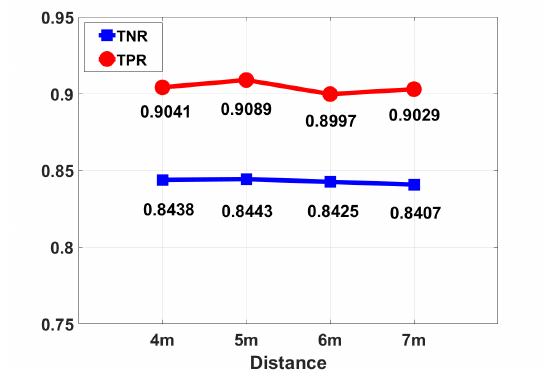
Figure 17. Performance results under different distances between TX and RX.